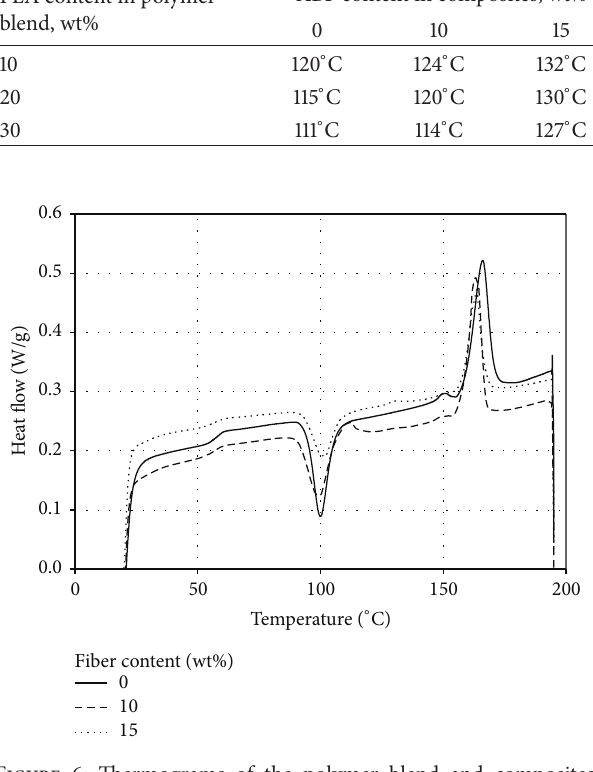
Figure 6: Thermograms of the polymer blend and composites containing 20 wt% of